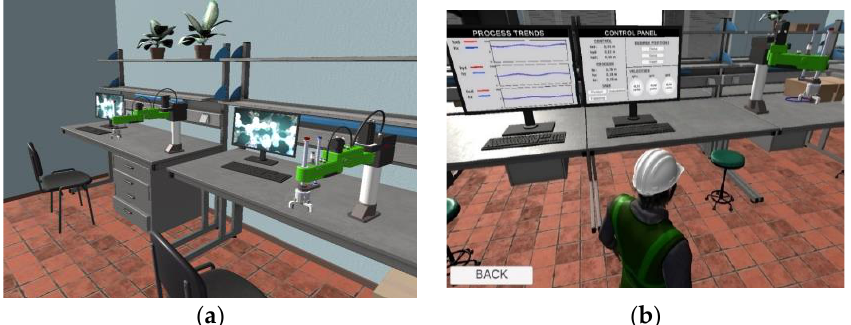
Figure 9. Virtualized laboratory environment for advanced controller application and testing of assigned tasks.( a ) Laboratory Environment ( b ) Assigned tasks.